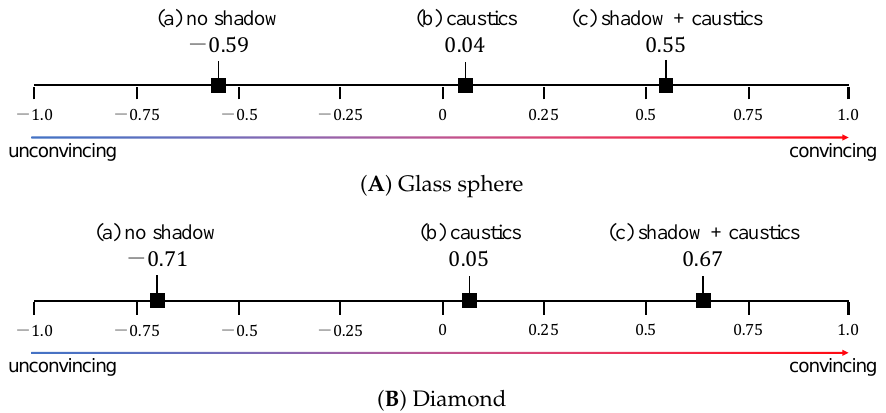
Figure 6. Results of the main